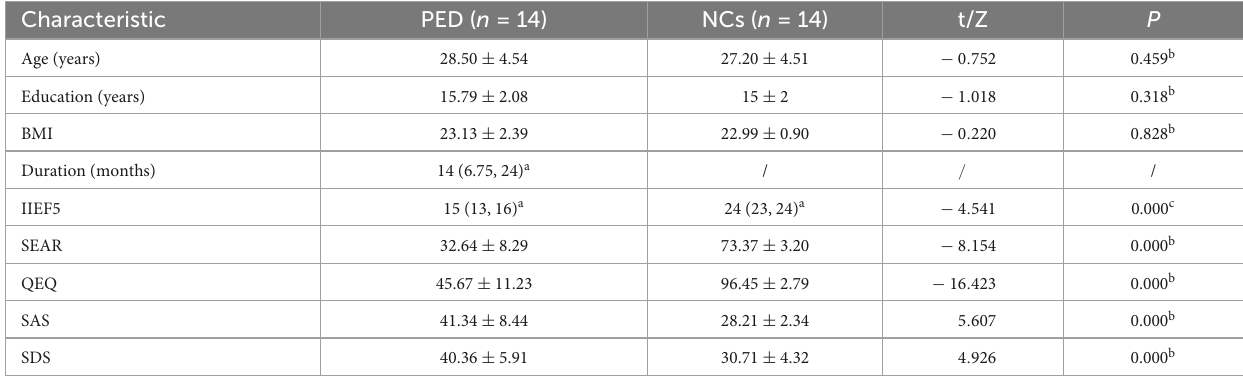
TABLE 1 Demographic and clinical conditions in patients with PED and NCs.